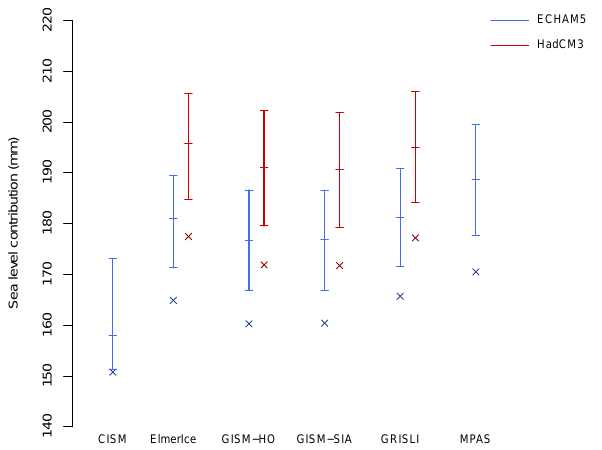
Fig. 2. As for Fig. 1, but at 2200.